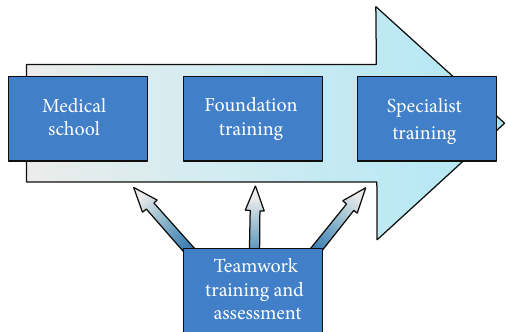
Figure 2: Recommended implementation of teamwork training and